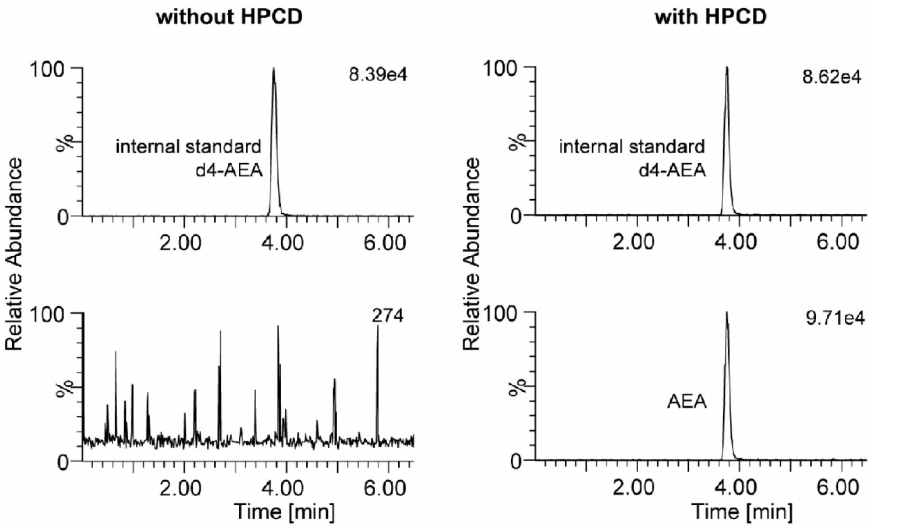
Figure 5. LC-MS/MS analysis of anandamide in microdialysate samples from in vivo experiments in abdominal adipose tissue. The internal standard, d4-anandamide, was spiked to the microdialysate samples. A chromatogram from dialysate obtained without HP-ß-CD is shown in the left panel. The absence of any anandamide peak (lower left panel) shows that the detected anandamide in microdialysate samples originates from endogenous sources and is not a contamination of d4-anandamide serving as the internal standard (lower right panel).